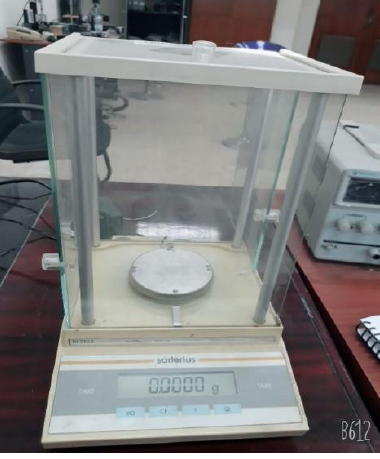
Fig. 6. Sensitive balance device (Model type: Sartorius - readability: 0.1 mg). Average Improvement of Material Removal (ΔMR). Run No.